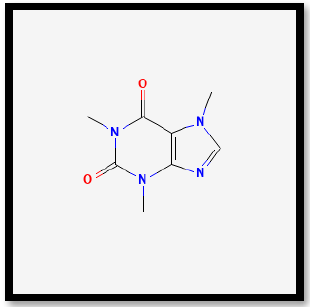
Figure 7. Chemical structures of caffeine.